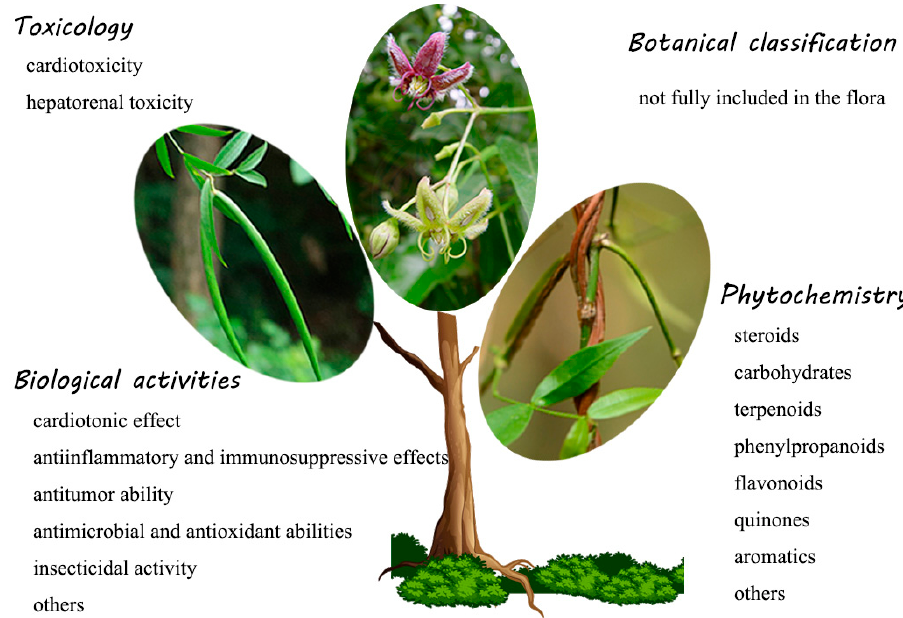
Figure 1. The outline and some representative plants of the genus Periploca . (Left: The fruits of P. forrestii ; Centre: The flowers of P. sepium ; Right: The stems of P. forrestii . The center and right pictures were downloaded from Plant Photo Bank of China, PPBC.).